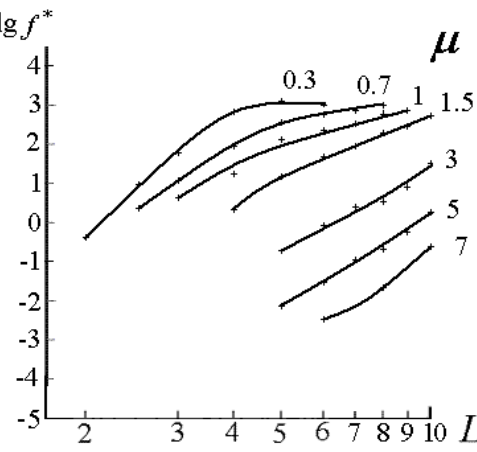
Figure 1. Functions f ∗ ( L ) for protons with different µ (from 0.3 to 7keVnT − 1 ) calculated with ISEE-1 data from Williams and Frank (1984) for a slightly disturbed (Kp ≤ 2) period 17 November 1977. Here µ is given in kiloelectronvolt per nanotesla. The value of f ∗ (s 3 cm − 6 ) is 1.836 × 10 30 f .